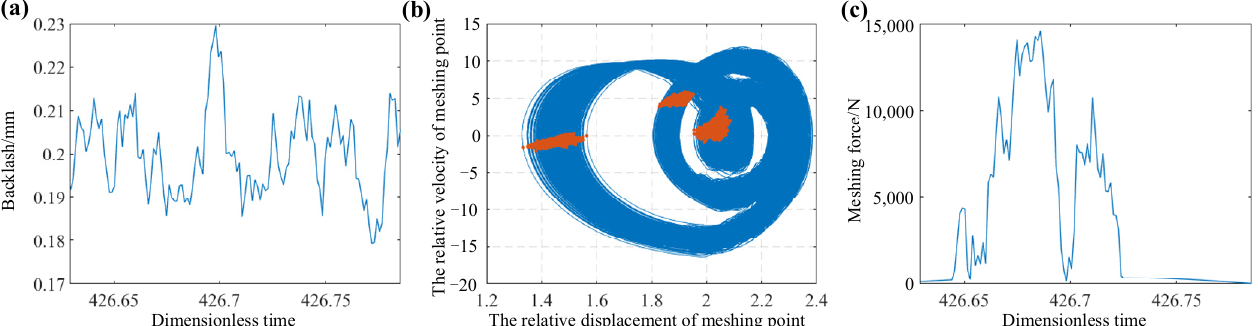
Figure 3. System response and meshing force with D = 1.43. ( a ) Backlash with fractal characteristics. ( b ) Phase diagram and Poincare section diagram. ( c ) Meshing force.